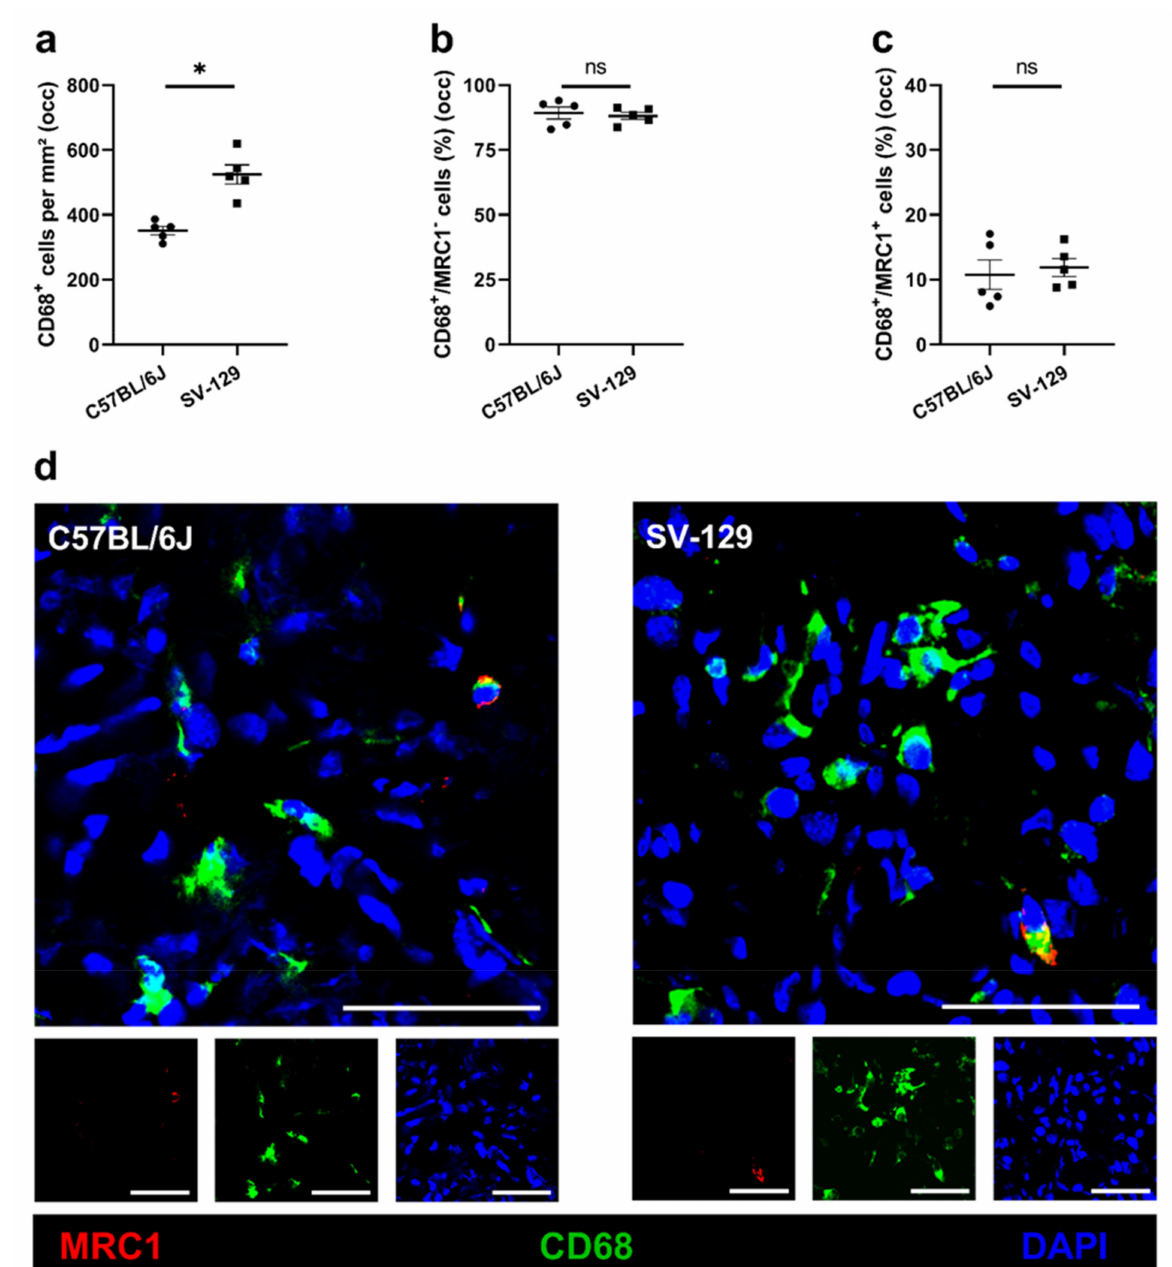
Figure 5. C57BL/6J mice show a lower number of macrophages than SV-129 mice at the side of sterile, ischemic inflammation, while macrophage polarization is unaffected. Scatter plots display ( a ) the number of macrophages (CD68 + /DAPI + ) per mm 2 , ( b ) the percentage of M1-like polarized macrophages (CD68 + /MRC1 − (mannose receptor C-type 1)/DAPI + ), and ( c ) the percentage of M2-like polarized macrophages (CD68 + /MRC1 + /DAPI + ) in occluded (occ) ischemic gastrocnemius muscles isolated from C57BL/6J and SV-129 mice 7 days after femoral artery ligation (FAL). A defined ischemic area (1.5 mm 2 ) of muscle tissue was analyzed per mouse. Data are means ± S.E.M., nüber = 5 per group. n.s. p ≥ 0.05, * p < 0.05 ( C57BL/6J vs. SV-129 ) by unpaired, two-sided Student’s t -test. ( d ) Representative immunofluorescence staining of ischemic gastrocnemius muscles of C57BL/6J (left) and SV-129 mice (right) collected 7 days after FAL. Cells were stained with an antibody against MRC1 (red), CD68 (green), and DAPI (blue) to label nucleic DNA. Scale bars: 50 µ